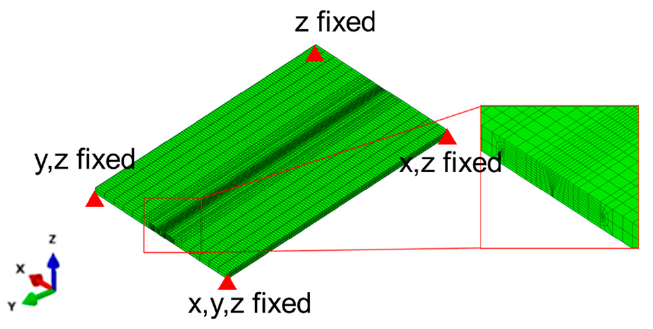
Figure 9. Solid mesh system and boundary conditions for butt-joint model mechanical analysis. The arc efficiency was assumed to be 0.85. The heat losses due to radiation and Table 2. Heat source parameters. convection were considered together using the constant film coefficient. The latent heat was assumed to be 273,790 W, with the solidus and liquidus temperatures being taken as 1427 ◦ C and 1482 ◦ C, respectively. The emissivity coefficient was taken to be 0.32. The other thermal and mechanical properties [18] used in this analysis are presented in Figure